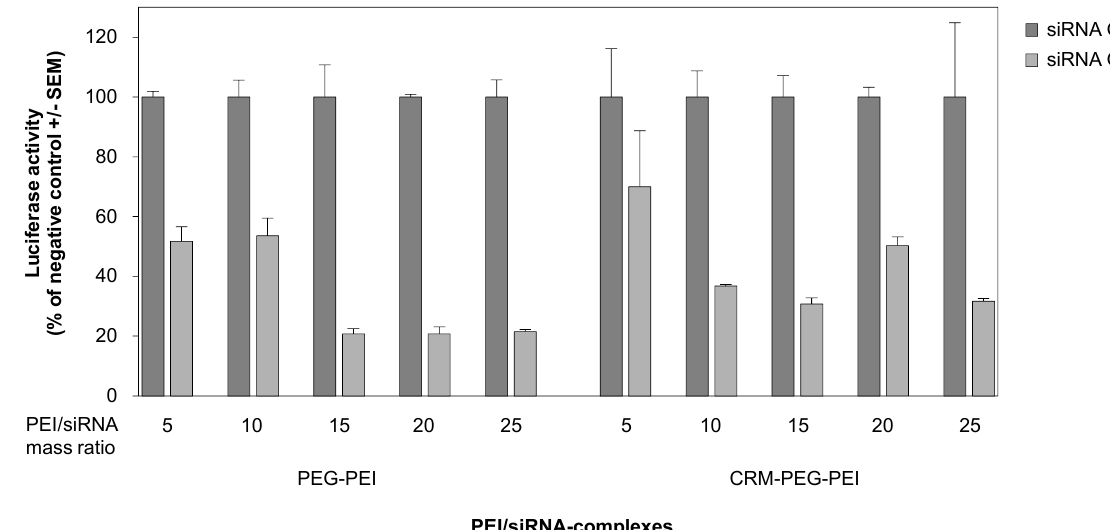
Figure 3. Determination of optimal (CRM197-)PEG-PEI/siRNA complex stoichiometries in an in vitro knockdown assay. The human glioblastoma cell line U87, transiently expressing luciferase, was transfected with PEG-PEI/siRNA complexes (left) or CRM197- PEG-PEI/siRNA complexes (right) at different (CRM197-)PEG-PEI/siRNA mass ratios, with complexes containing a non-specific siRNA (siRNA GL2; dark grey) or the luciferase-specific siRNA GL3 (light grey). Knockdown efficiencies after 48 h were determined by measuring luciferase activities in relative light units, and the respective negative controls are set to